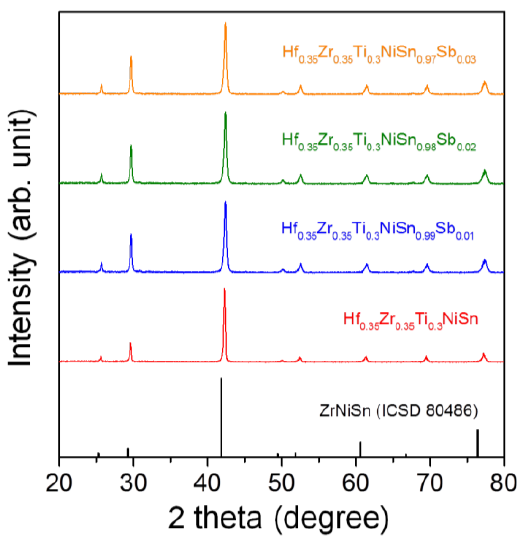
Figure 2. X-Ray Diffraction ( XRD) patterns for SPSed bulks of Hf 0.35 Zr 0.35 Ti 0.3 NiSn 1- x Sb x ( x = 0, 0.01, 0.02, 0.03). Standard ZrNiSn XRD pattern is also shown for comparison.